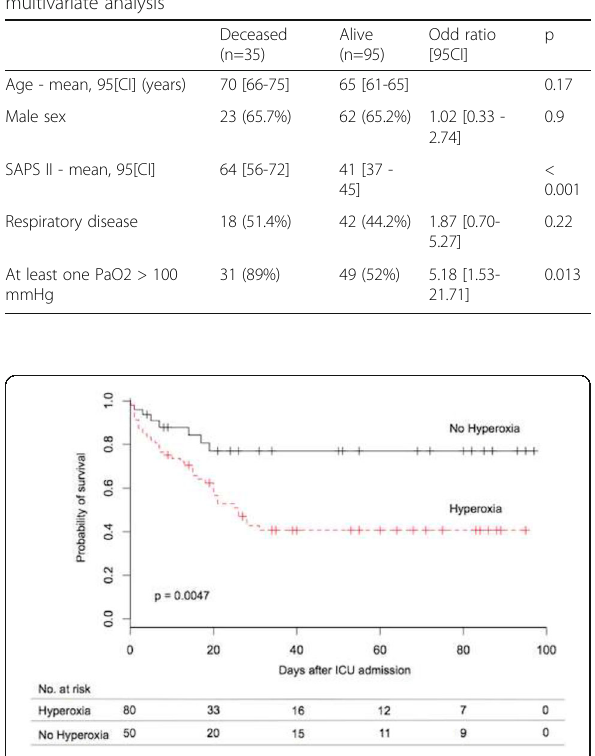
Fig. 1 (abstract 0214). Kaplan-Meier estimation of overall